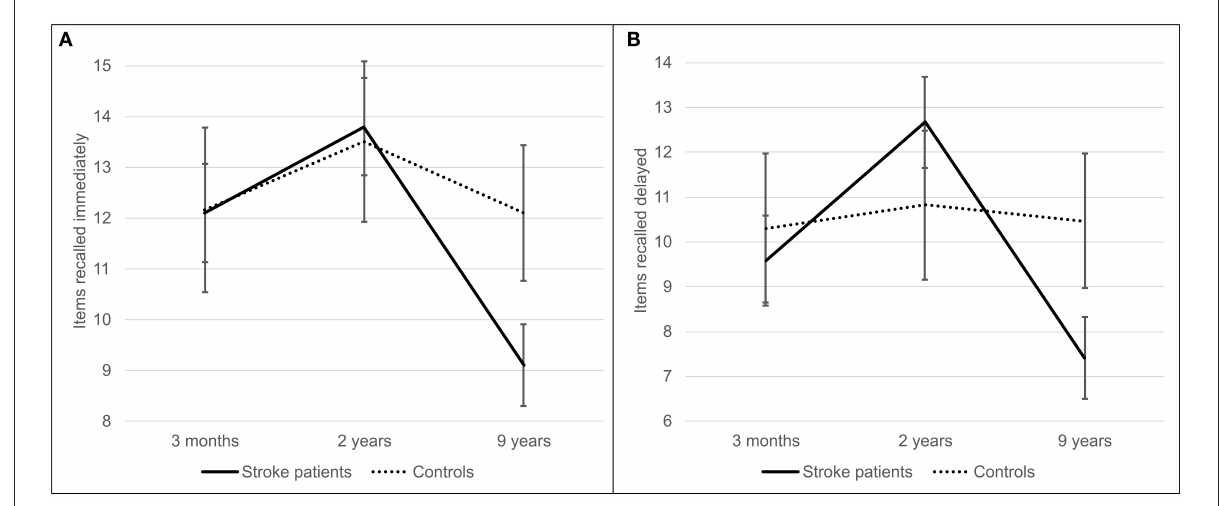
FIGURE2 Immediate (A) and delayed (B) recall of a story from the logical memory test component of the wechsler memory scale. Stroke patients (solid line) recalled items at three follow-up time points–3 months, 2, and 9 years poststroke—and were compared to stroke-free controls (dashed line). Error bars represent 95% confidence